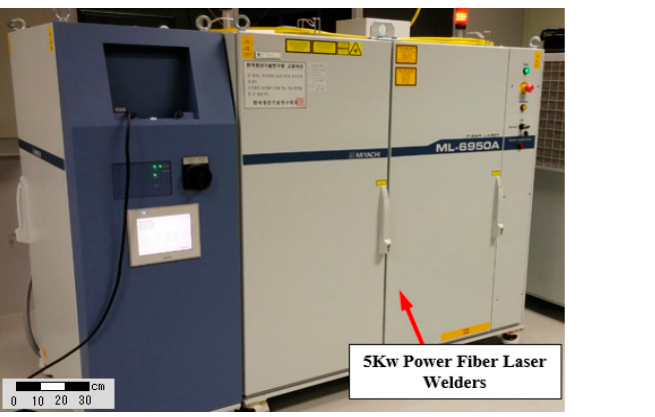
( b ) Optical system and jig shape assembled in a six-axis robot. Figure 1. Equipment for fiber laser welding. Figure 1. Equipment for fiber laser